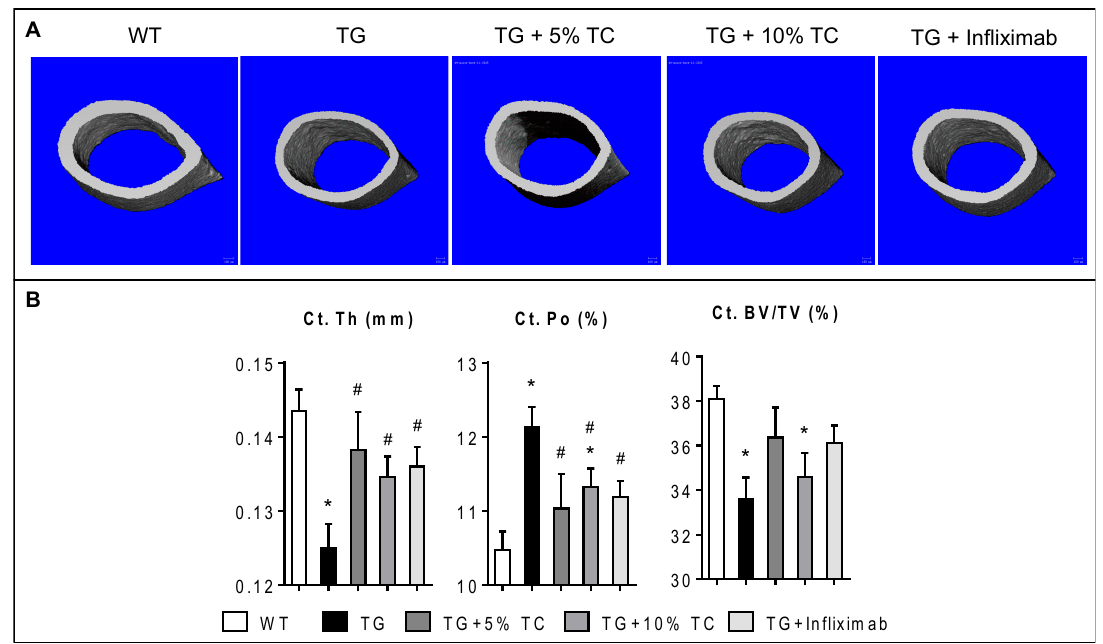
Figure 3. TC diet improved modification of cortical bone structure by inflammation. ( A ) Microcomputed tomography ( µ CT) scans representing sections of cortical bone were taken for femurs of WT, TG, TG + 5% TC, TG + 10% TC, and TG+infliximab mice. ( B ) Cortical thickness (Ct.Th), porosity (Ct.Po), and bone mass (Ct.BV/TV) were quantified using µ CT analysis. Values are mean ± SEM ( n = 4–8 per group). *, p < 0.05 vs. WT; #, p < 0.05 vs. TG.